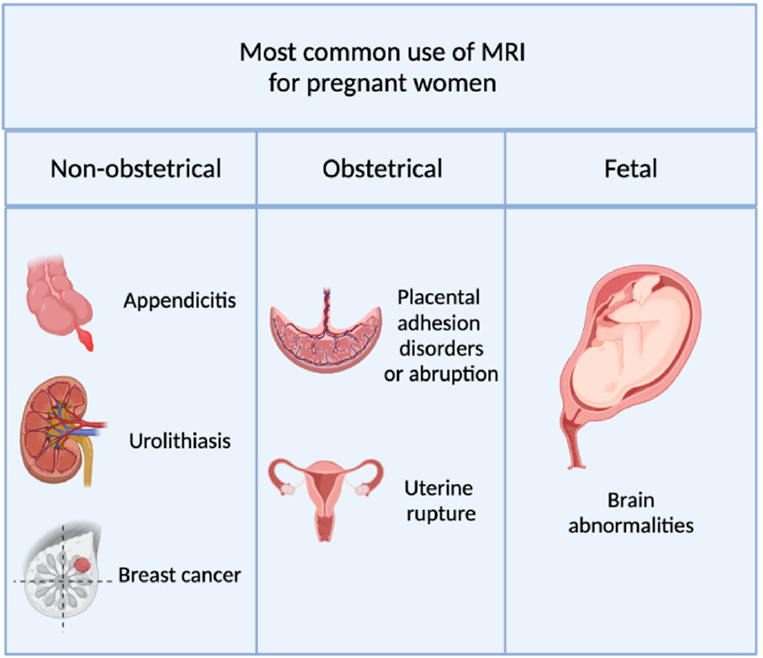
Figure 1. Summary of the most common indications for MRI during pregnancy.